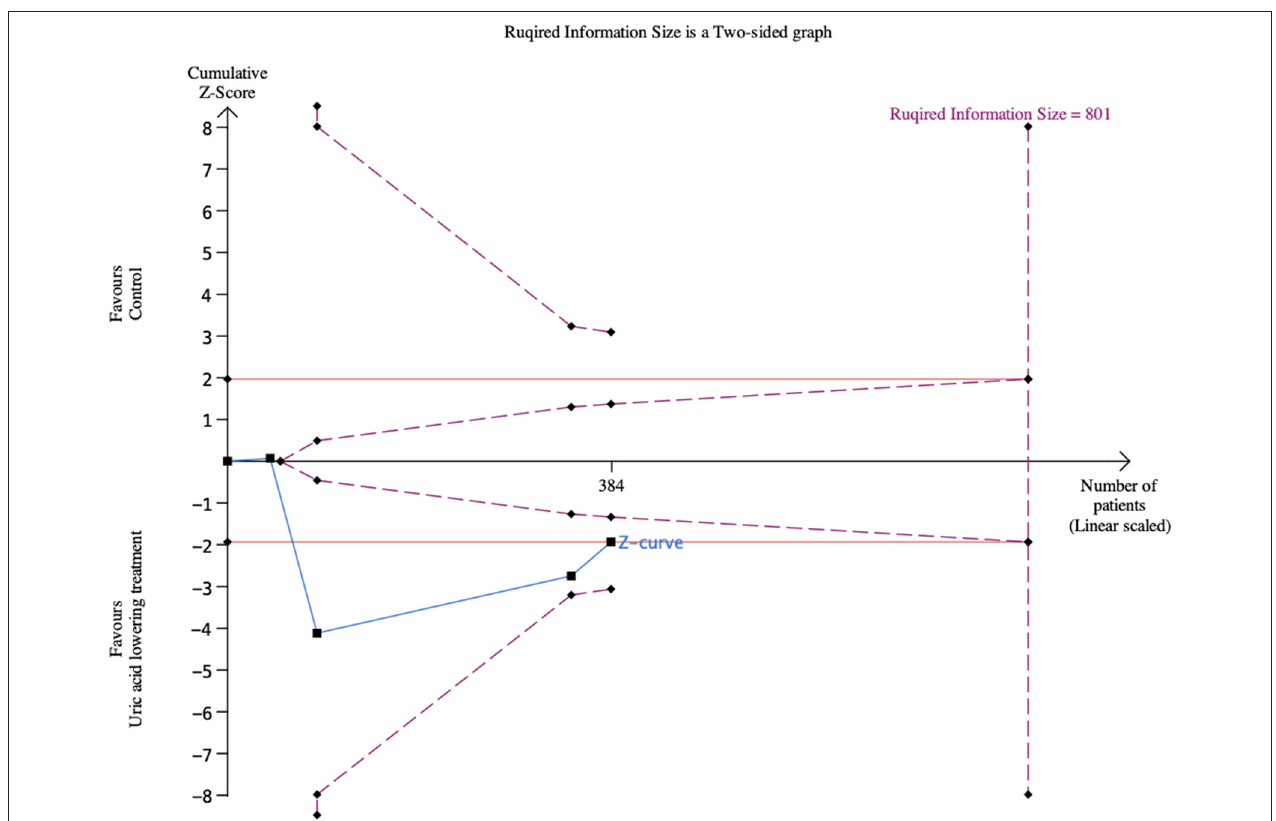
FIGURE 9 | Trial sequential analysis of 6-Min Walk Test.